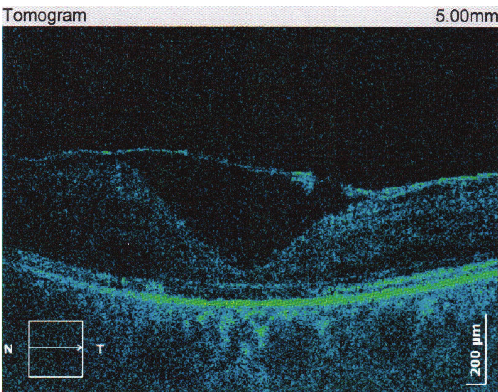
Figure 5: Macular edema and epiretinal membrane as complication of periphlebitis in patient with MS (right eye).